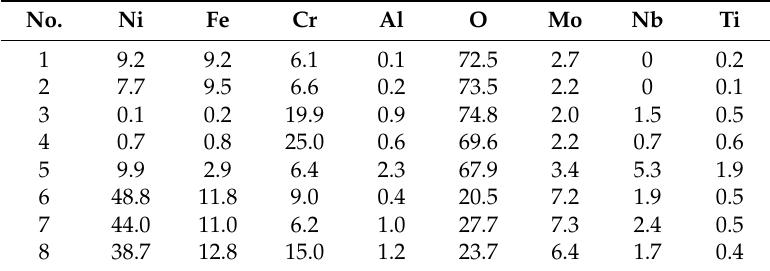
Figure 5. The TEM images of the oxide scales formed on IN718 raw powders after oxidation on 800 ◦ C for 5 min in vacuum (<10 − 3 Pa) ( a ) and in air ( b ). Table 2. Chemical composition of the scale formed on 800 ◦ C for 5 min in air obtained from EDS point analysis (in atom %).